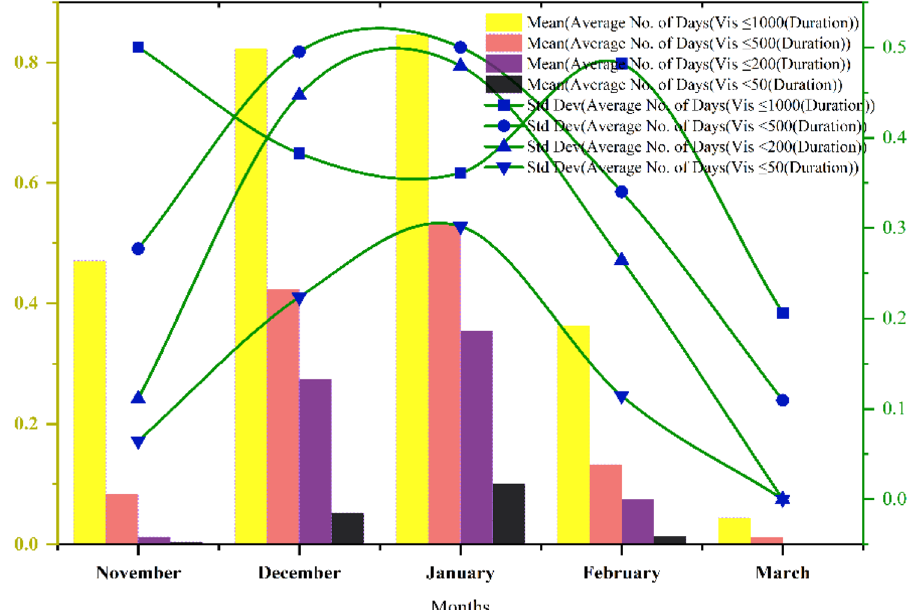
Fig. 5 Statistical analysis of the number of foggy days for November to March for the JPNI Airport Patna (Foggy days represented as at least once in a day visibility ≤ 1000